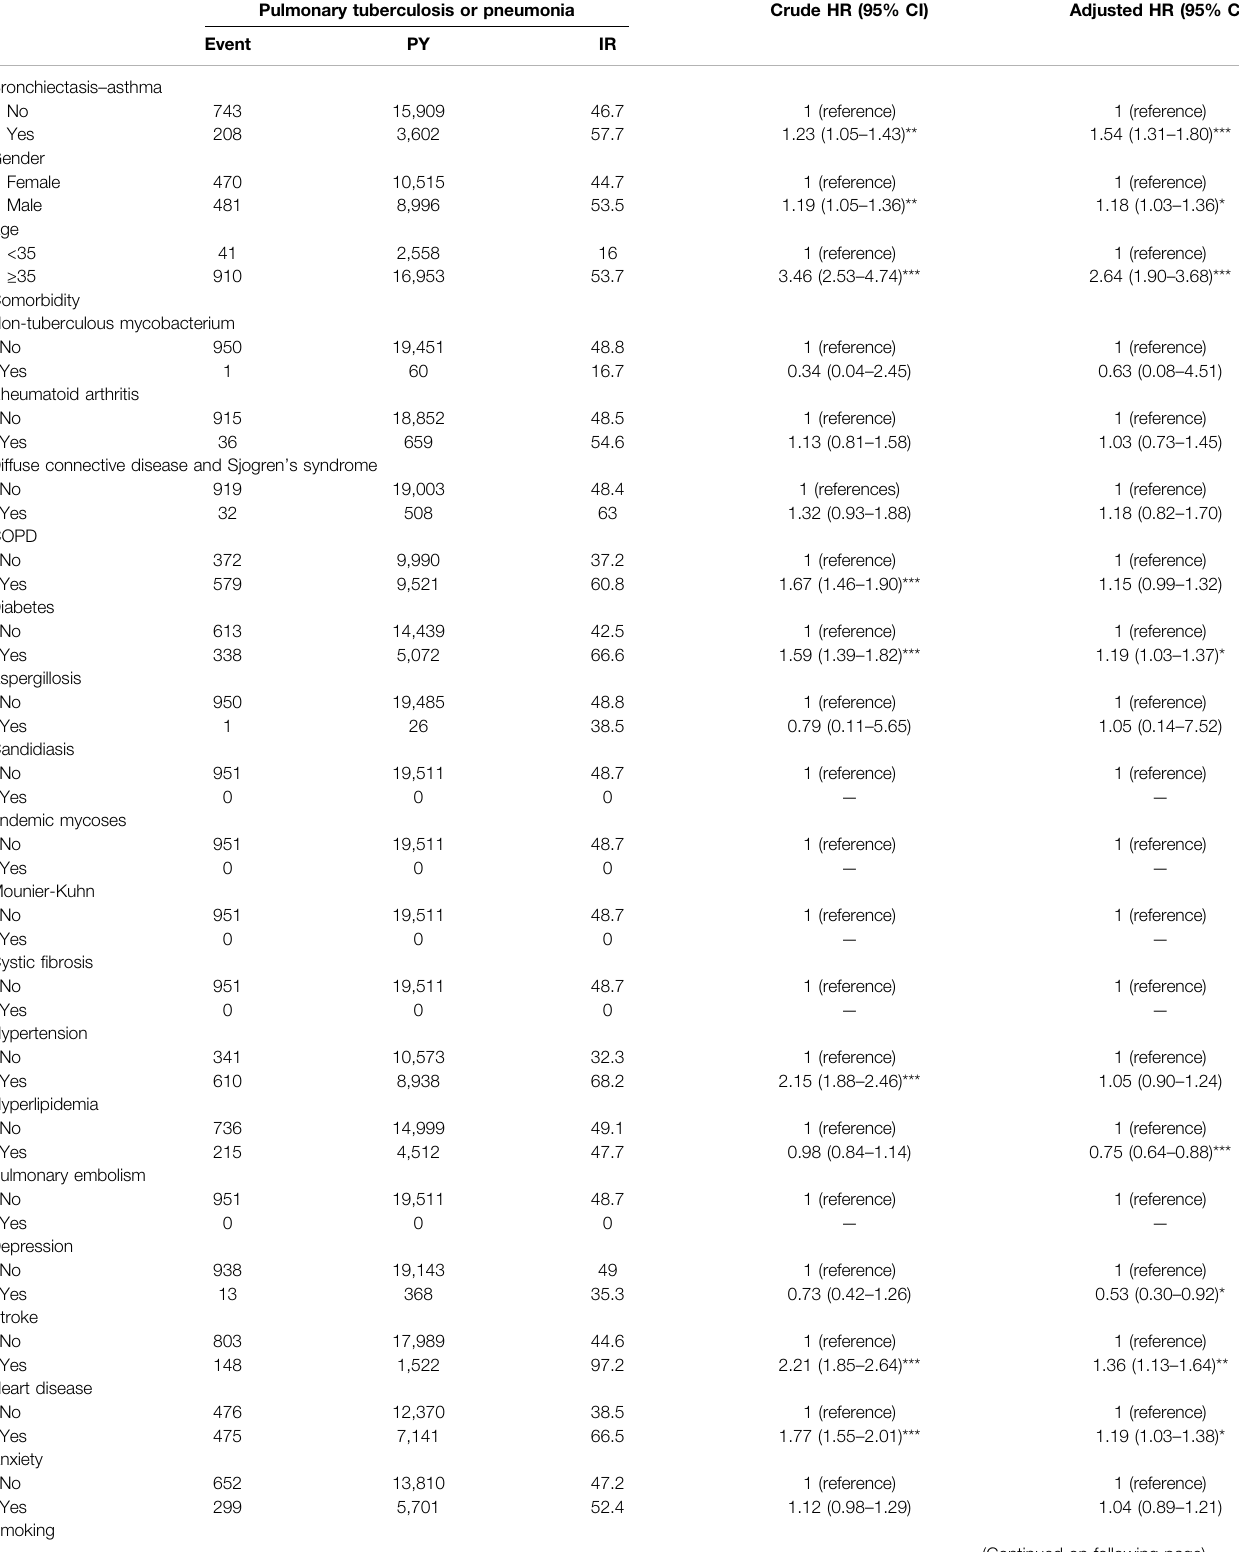
TABLE 2 | Cox model-measured hazard ratios and 95% con fi dence interval of pulmonary tuberculosis or pneumonia associated with gender, age, comorbidity, and medications after propensity matching of both the BCAS and non-BCAS